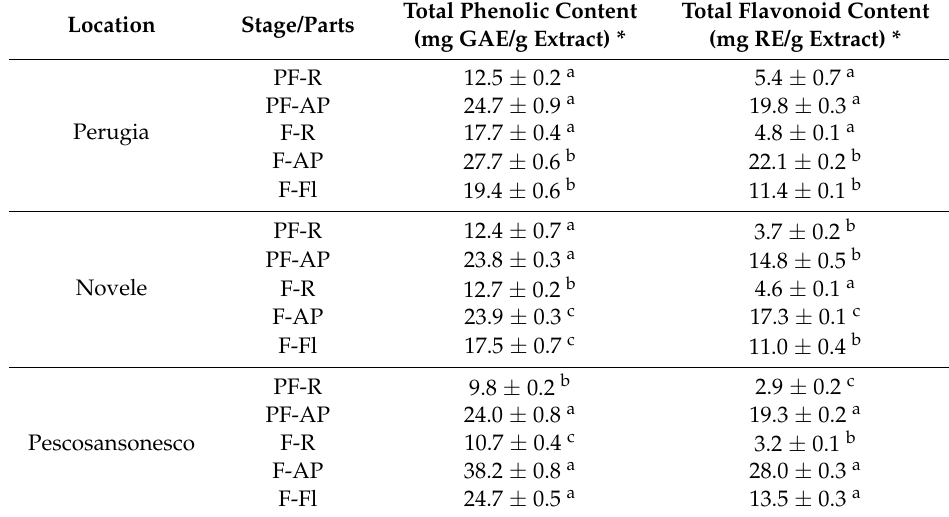
Table 1. Total phenolic and flavonoid content of different parts of A. lutea collected from three different locations in